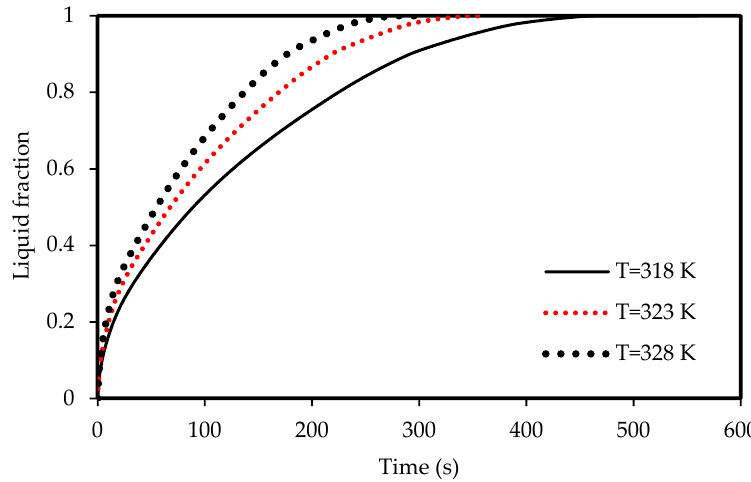
Figure 20. Contours of the liquid-fraction and temperature in a solidification process for the double width (2 W) horizontal corrugated channel.